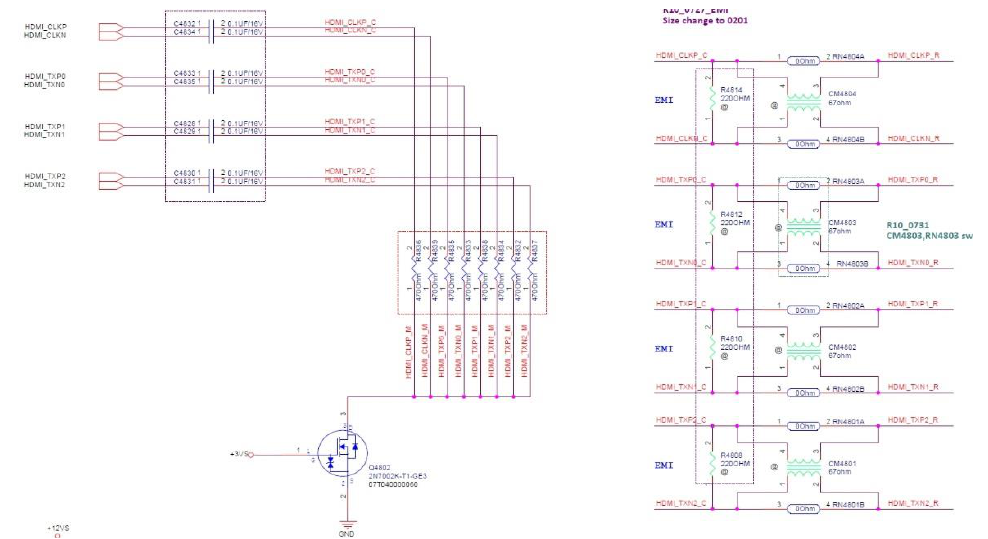
Figure 12. Schematic diagram of staggered wire around the object to be measured .